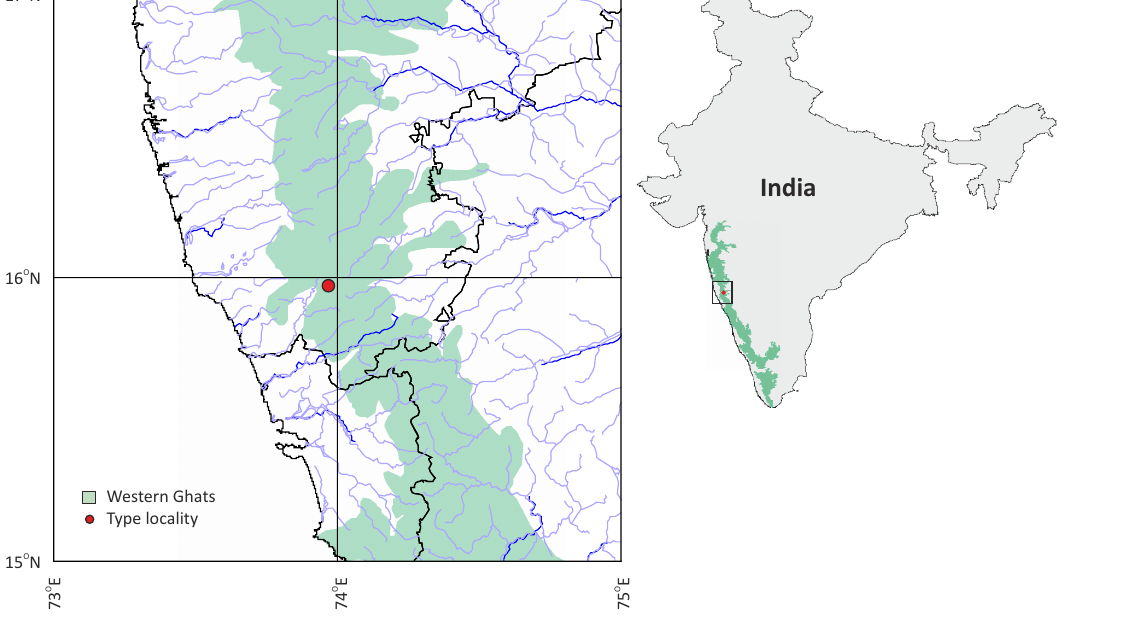
Figure 1. Type locality of Indirana chiravasi sp. nov.